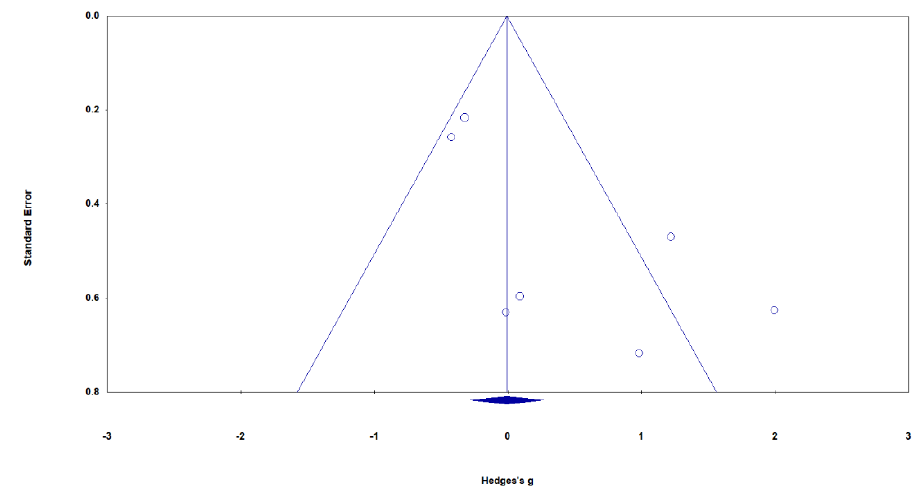
Figure 4. Funnel plot demonstrating the bias of VR-based exposure therapy on PTSD symptoms.